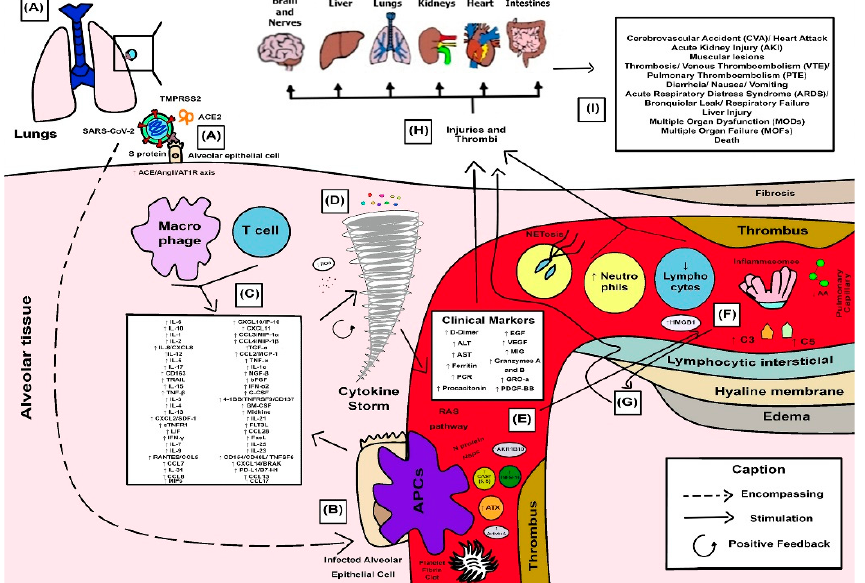
Figure 4. Hyperinflammatory response in patients with COVID-19. It describes the stages of immune processes in the human body from viral entry into the alveolar epithelial cell, the processes of adhesion and recognition by APCs, the activation of cell signaling pathways, secretion of inflammatory mediators by immune cells responsible for the generation of cytokine storms, the recruitment of co-stimulatory molecules of this inflammation, activation of proteases, inflammasomes, and coagulation factors, as well as the elevation of the patient’s clinical parameters that reflect pathological complications, which can be related to either local or systemic damage and lead to death. This didactic illustrative scheme for the hyperinflammatory response to COVID-19 is based on the results of this review. They are represented in chronological order of events by letters (A–Z).